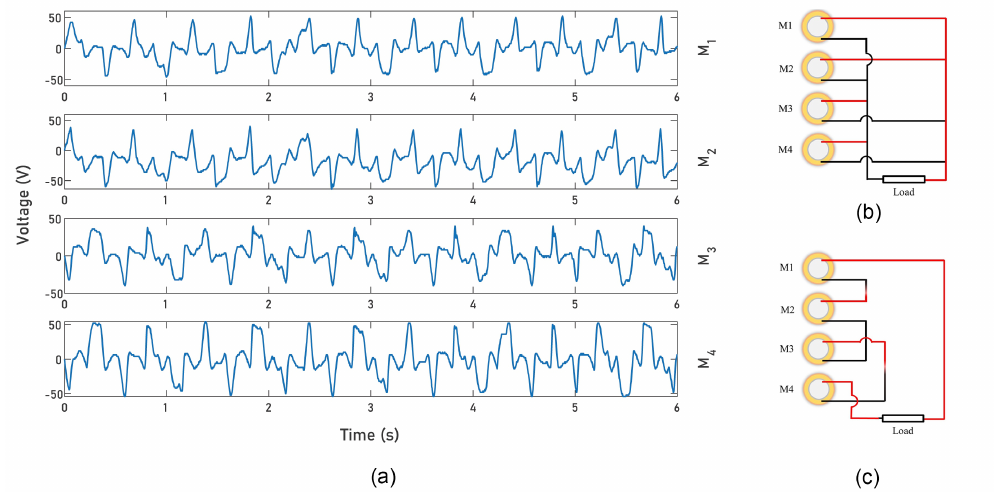
Figure 8. ( a ) Output voltages of all piezoelectric bender disks. ( b ) Schematic circuit diagram showing the parallel connection of the piezoelectric disks. ( c ) Schematic circuit diagram showing the series connection of the piezoelectric